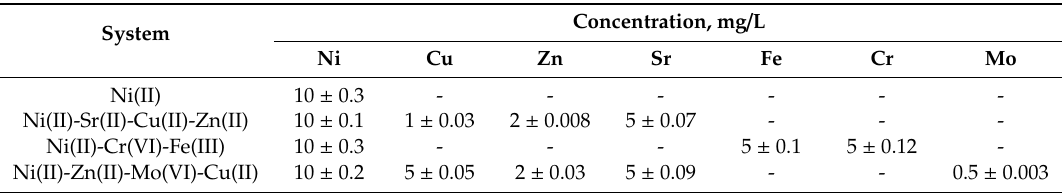
Table 1. Metal concentrations in analyzed